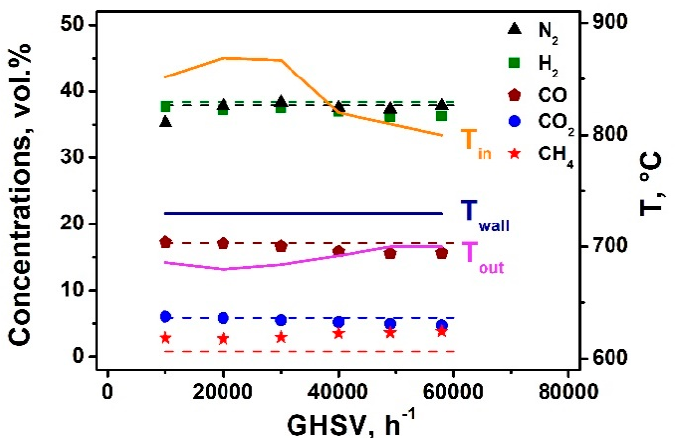
Figure 2. The inlet (T in ) and outlet (T out ) temperatures of the Rh-block, H 2 , N 2 , CO, CO 2 , and CH 4 concentrations (on a dry basis) as a function of space velocity (GHSV) for partial oxidation (PO) of methane-rich gas (MRG). Experimental conditions: GHSV 18,000–55,000 h − 1 , 1 bar pressure, reactor wall temperature 730 °C, reaction mixture (vol.%): 25.6 CH 4 , 13.4 O 2 , 10.5 H 2 O, and 50.5 N 2 . Points are experimental. Dashed lines are equilibrium concentrations.